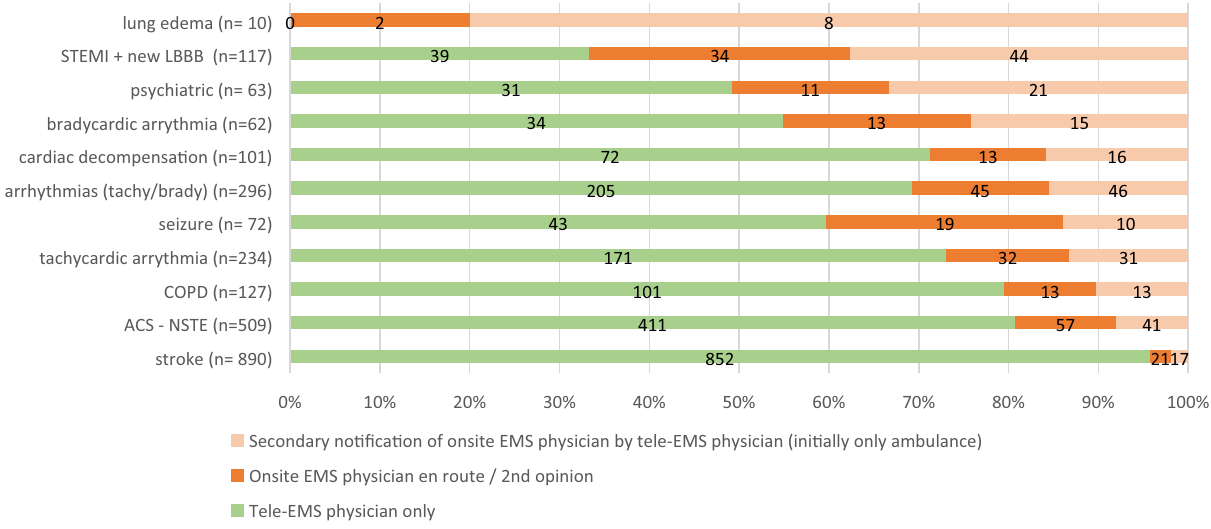
Figure 2. Distribution of tele- and onsite EMS physicians according to tracer diagnoses (brady- and tachycardic arrhythmias are subgroups of